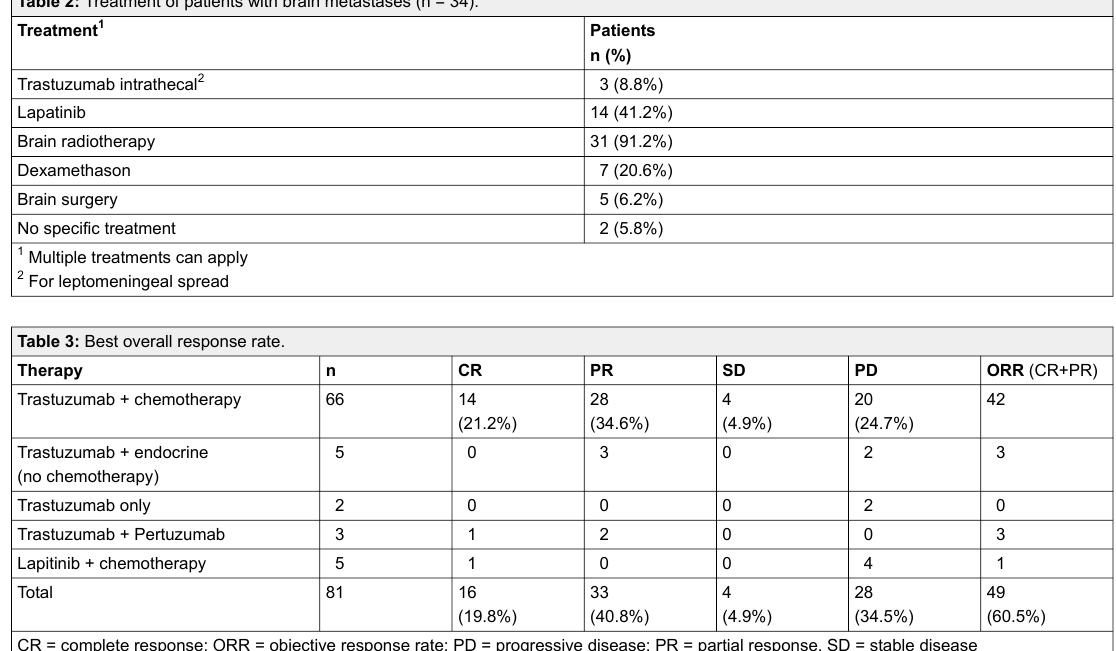
Table 2: Treatment of patients with brain metastases (n = 34).